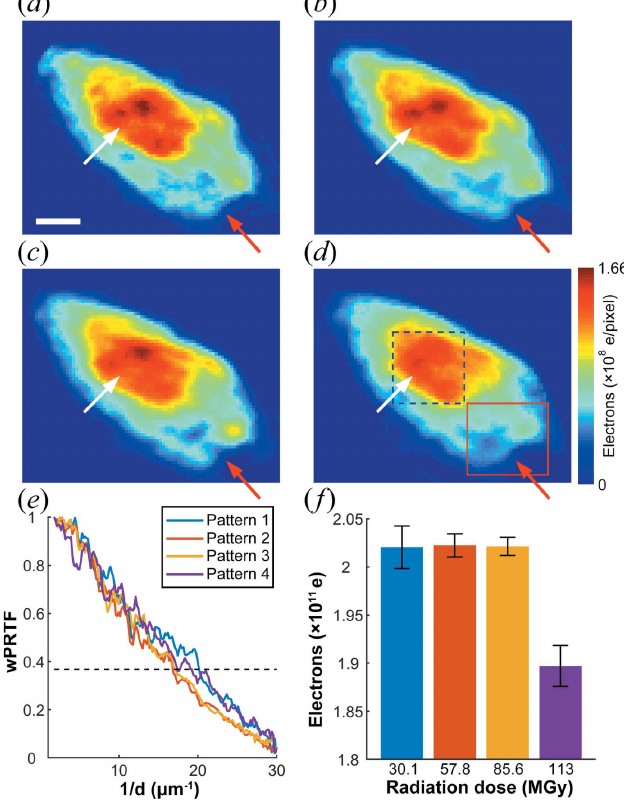
Figure 6 ( a )–( d ) Reconstructions corresponding to the first to the fourth diffraction patterns (in Fig. 5), respectively. The high- and low-density areas are outlined by the dashed blue and solid red rectangles, respectively. With increasing cumulative radiation dose, the structures in both high- and low-density areas (indicated by the white and red arrows, respectively) change. The scale bar is 200 nm. ( e ) wPRTF curves of the four diffraction patterns. The value of the dotted line is 1/e, which serves as the criterion for the resolution. ( f ) The total number of electrons calculated in the mitochondrion under different radiation